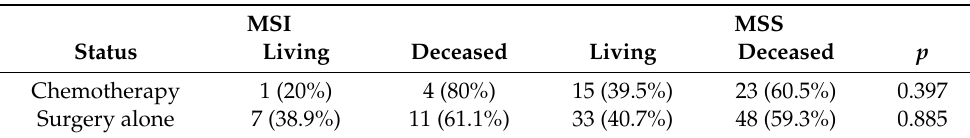
Table 4. Association of MSI status with perioperative chemotherapy administration and survival. MSI: microsatellite instability; MSS: microsatellite stability.